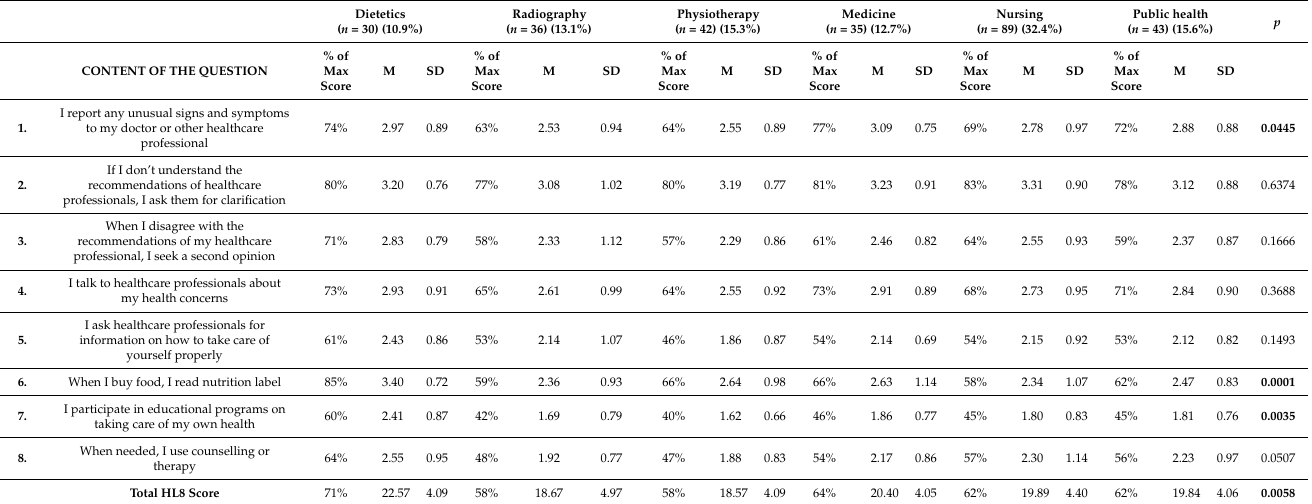
Table 9. Health literacy vs.